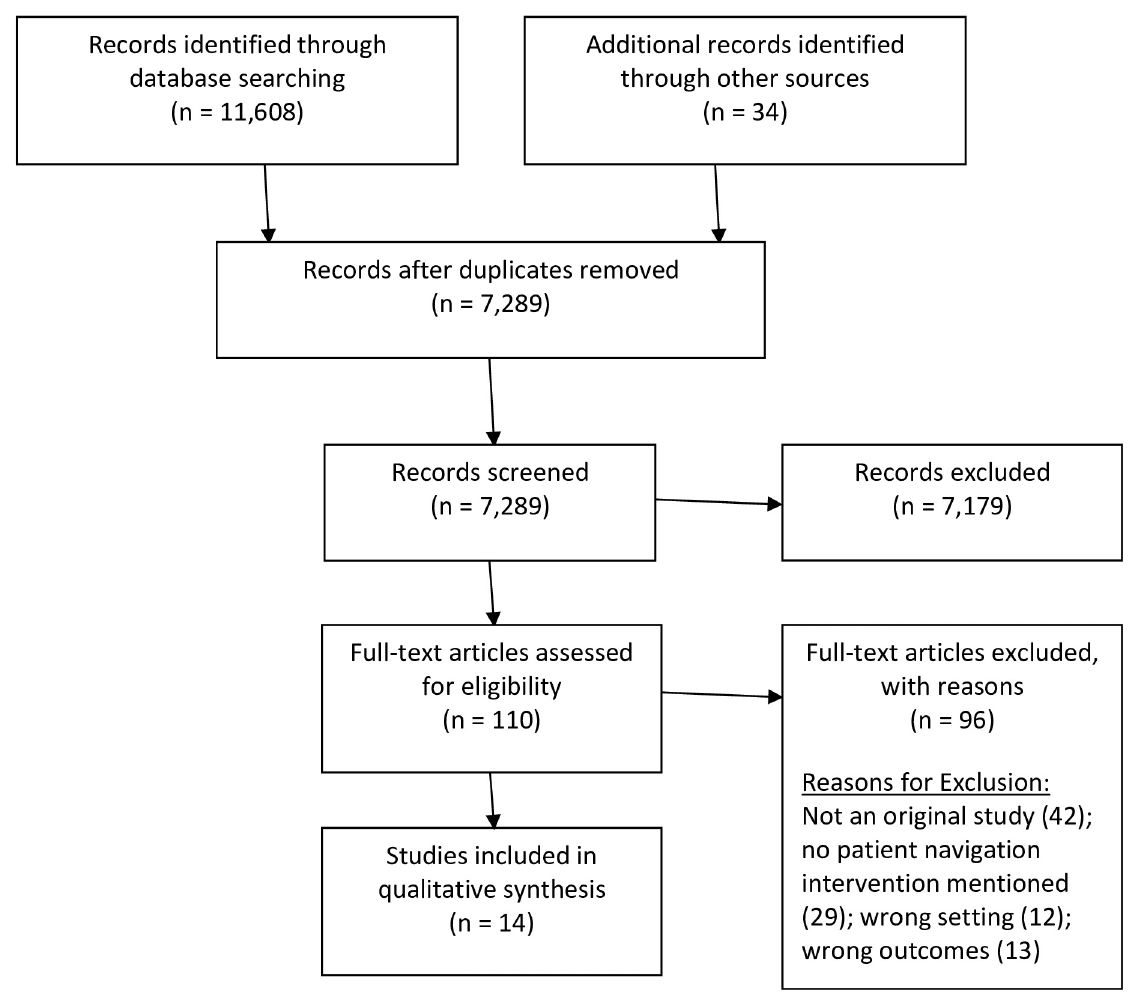
Fig 1. PRISMA flow